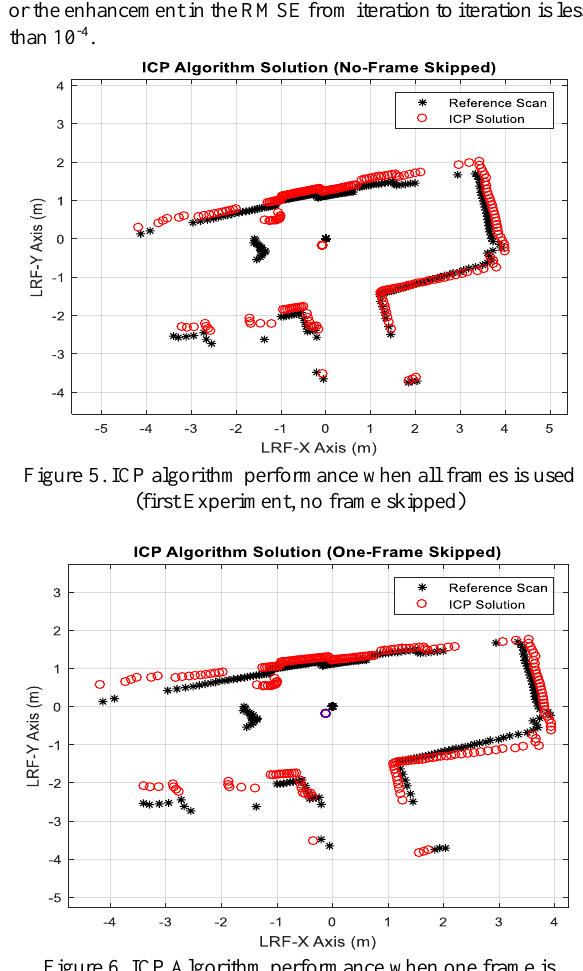
Figure 8. Vehicle-Model ICP performance.